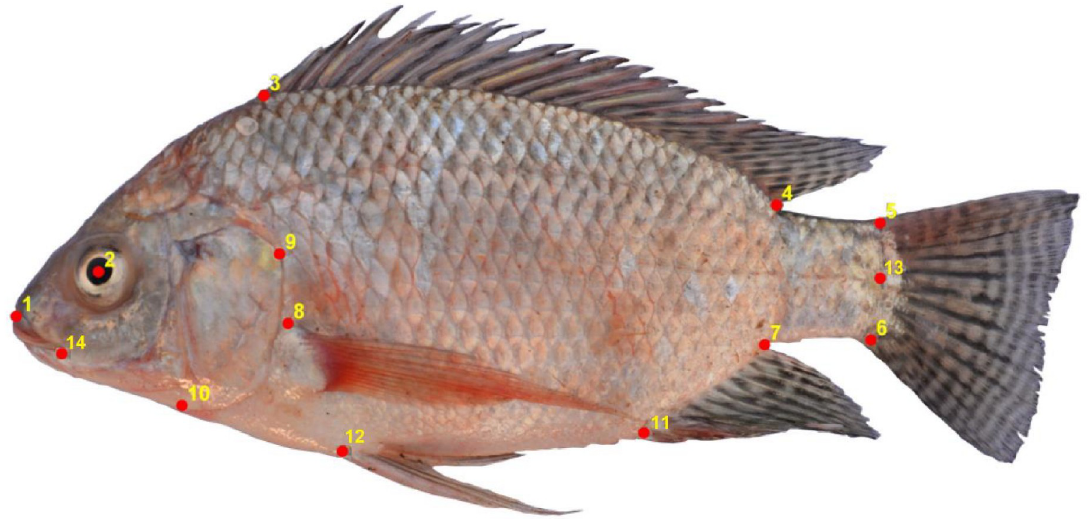
Fig 2. Landmark positions on an image of a Nile tilapia fish. A classical morphometrics analysis of Ethiopian Nile tilapia is based on the 14 landmark positions which we illustrate in this image of a Nile tilapia fish.